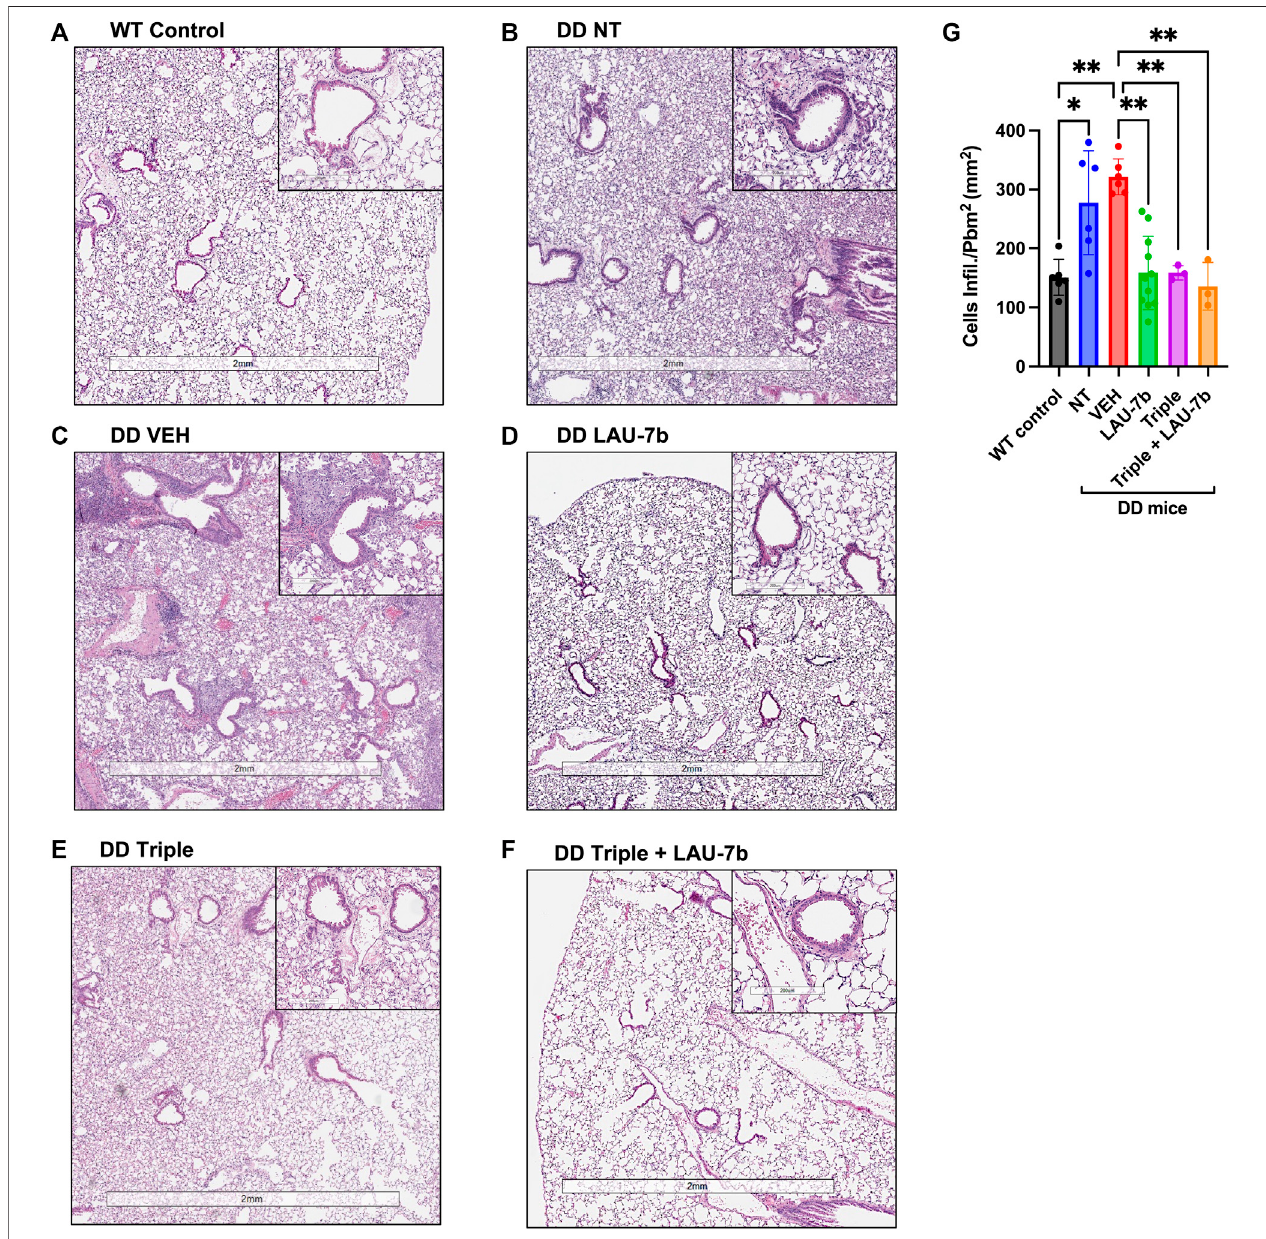
FIGURE3| Airwayhyperplasia andcellular in fi ltration in thelungsofWild-type (WT) andF508del/F508del (DD)mice;Hematoxylinand eosin(H&E)staining. (A) WT control mice (non-treated, NT and vehicle, VEH) (B – F) DD NT, VEH, LAU-7b, Triple and Triple + LAU-7b, respectively. (G) LAU-7b and Triple therapy treated DD mice havesigni fi cantlylowerlungcellin fi ltrationcomparedtoplacebotreatedDDmice.Foreachmouse,measurementsweredonewithatleastfourdifferentairwaysperlung. Quanti fi cation wasdone bycounting the number ofin fi ltrating cells around each of thefour airways per lung and normalized bydividing thesquareof the perimeter “ in millimeter ” of the airway basement membrane. n equal 3 – 11 mice for each group, Two-way ANOVA with Bonferroni correction where * p < 0.05, ** p < 0.01.